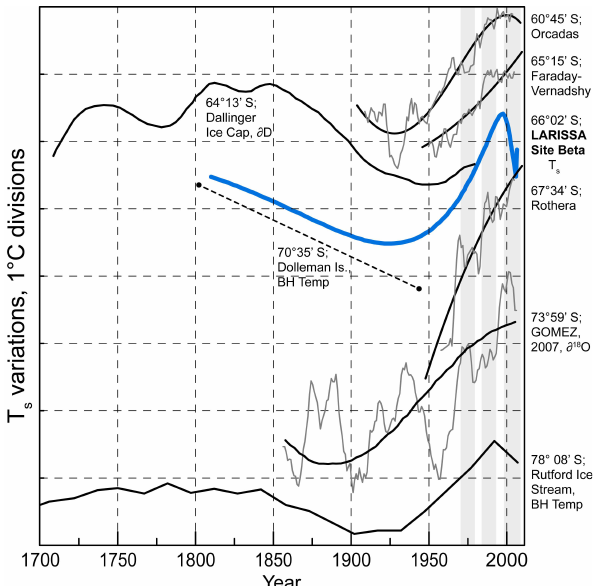
Fig. 4. Temperature histories from weather stations, borehole tem- peratures, and ice core isotope-derived records for sites on the Antarctic Peninsula and the adjacent West Antarctic Ice Sheet (see locations in Fig. 1). Shaded areas are the time intervals for which weather station data are available for the L-B T s reconstructed data used in 0 a(l) calculations (Table